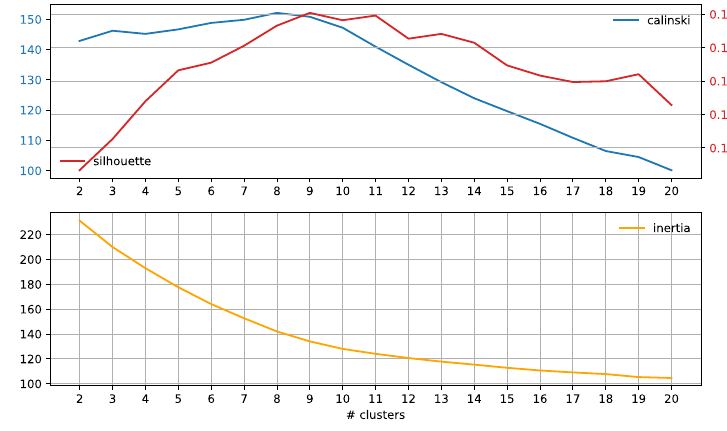
Figure A22. Subreddit Thritis.